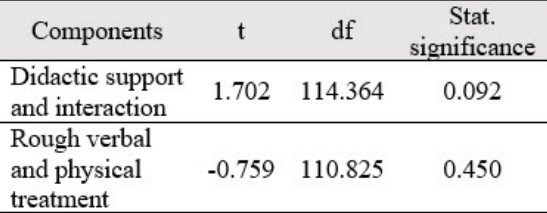
Table 6. Results of the t- test